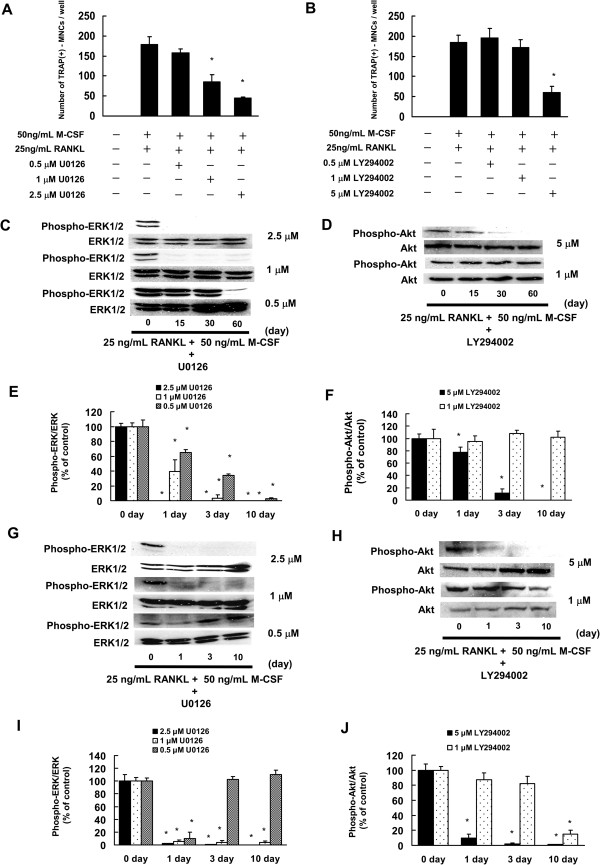
U0126 (MEK1/2 inhibitor) or LY294002 (PI3K inhibitor) inhibited osteoclast formation. (A, B) C7 cells were treated with 0.25, 0.5, 1, or 2.5 μM U0126 (A) or 0.5, 1, 2.5, or 5 μM LY294002 (B). Cells receiving U0126 or LY294002 were cultured in the presence of 25 ng/mL RANKL plus 50 ng/mL M-CSF. Cultures were fed every 3 days by replacing with 500 μL of fresh medium, with or without U0126, LY294002, RANKL, and M-CSF. Cultures were fixed and stained for TRAP-positive multinucleated cells per well was counted. These results are representative of 5 independent experiments. *P < 0.01 compared to 25 ng/mL RANKL plus 50 ng/mL M-CSF administration. (C, D) C7 cells were treated with 0.5, 1, or 2.5 μM U0126 or 1 or 5 μM LY294002 (D) for 24 h. Cells were cultured in the presence of 25 ng/mL RANKL plus 50 ng/mL M-CSF for 15, 30, and 60 min. (C) C7 cells were treated with 0.5 μM minodronate for 24 h. Cells were cultured in the presence of 25 ng/mL RANKL plus 50 ng/mL M-CSF for 15, 30, and 60 min. (E, F) Quantification of the amount of phospho-ERK1/2 or phospho-Akt normalized to the amount of total ERK1/2 or Akt, respectively. The results are representative of 5 independent experiments. *P < 0.01 compared to controls. (G, H) C7 cells were treated with 0.5, 1, or 2.5 μM U0126 or 1 or 5 μM LY294002 (D) for 24 h. Cells were cultured in the presence of 25 ng/mL RANKL plus 50 ng/mL M-CSF for 1, 3, and 10 days. (I, J) Quantification of the amount of phospho-ERK1/2 or phospho-Akt normalized to the amount of total ERK1/2 or Akt, respectively. The results are representative of 5 independent experiments. *P < 0.01 compared to controls.